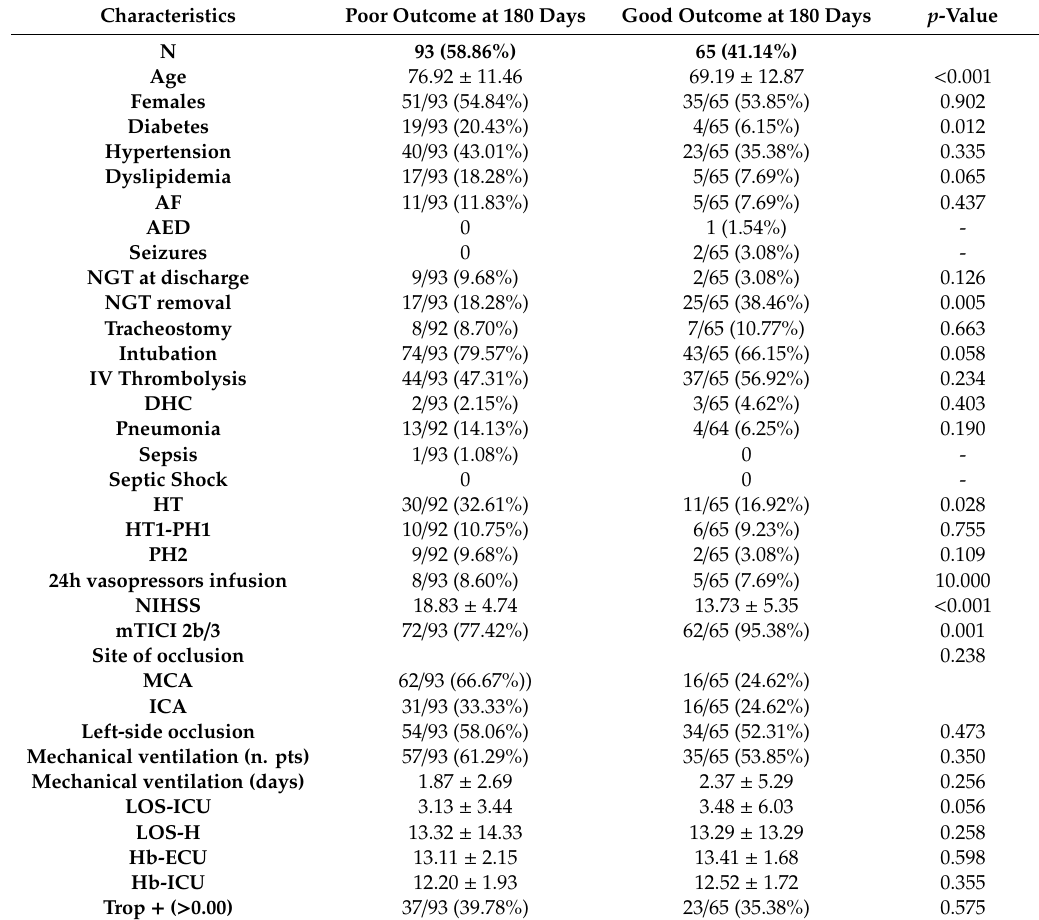
Table 3. Baseline, procedural and outcome parameters at 180-day